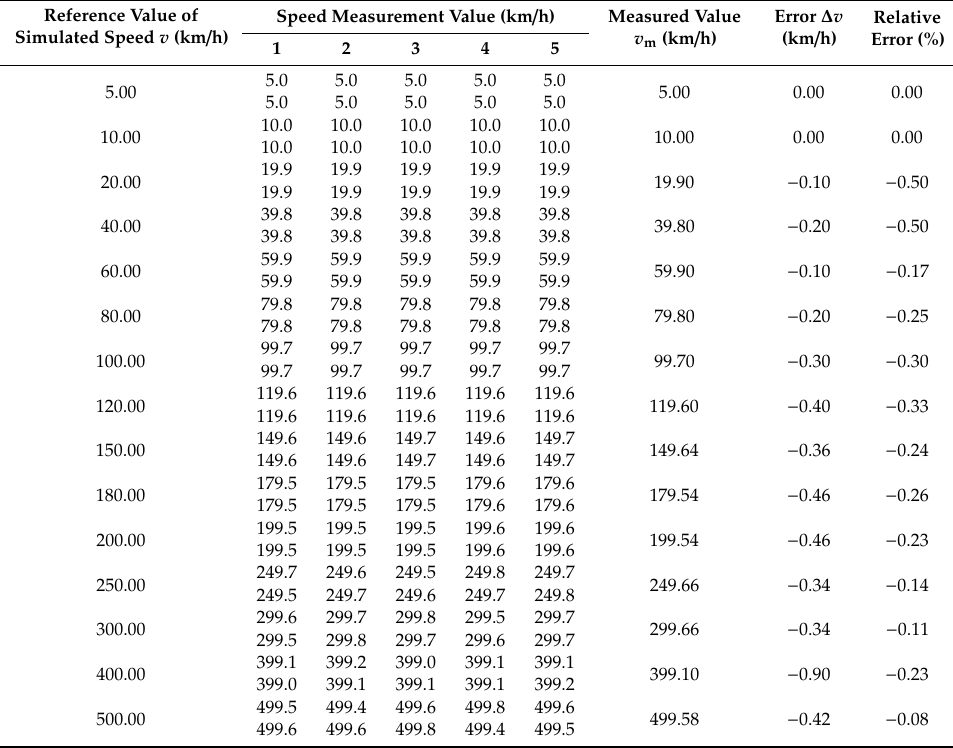
Table 11. Numerical speed calibration results of the DRS05S1c